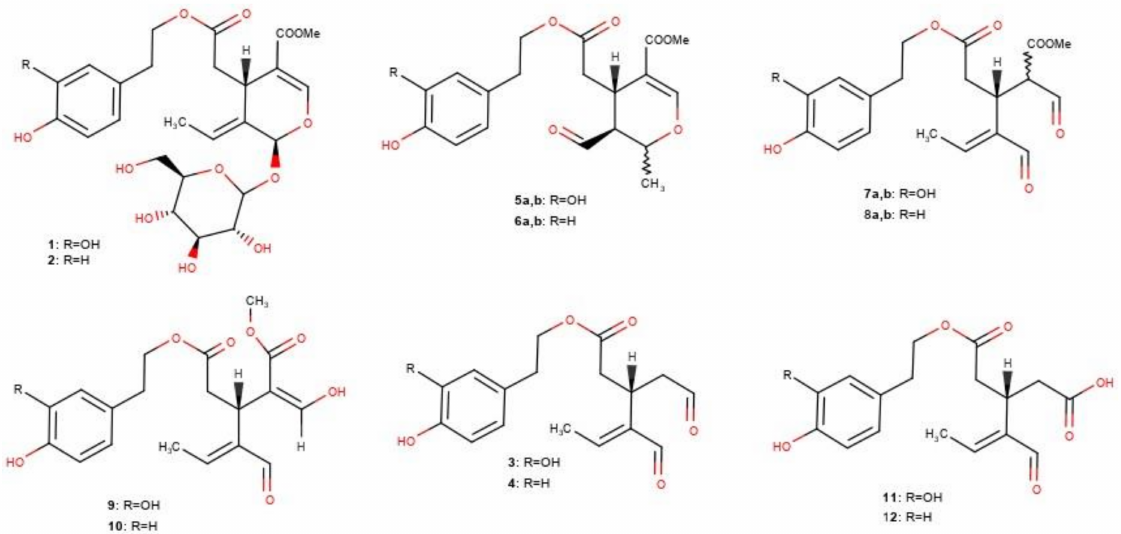
Figure 1. The structures of the studied phenolic